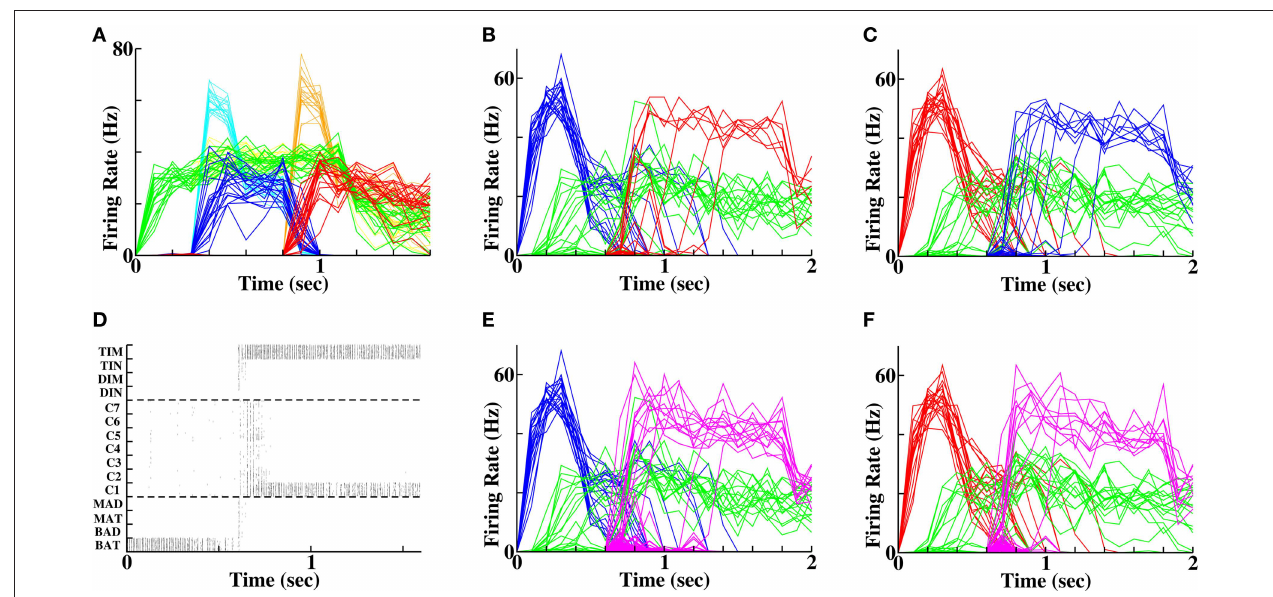
Figure 5 | Diminished forward and reverse recall following weaker prior stimuli. (A) Weak stimulation protocol. Bold green, blue and red traces represent population-averaged activity of cells representing context (“C1”), first word (“BAT”) and second word (“DIN”) respectively. Faint traces in yellow, cyan and orange reproduce the traces under a strong stimulus for comparison. Note the reduced peak height, but identical final firing rates following weak stimuli. (B) Forward recall at 35% success (compare Figure 4D with identical color scheme). (C) Reverse recall at 50% success (compare Figure 4F with identical